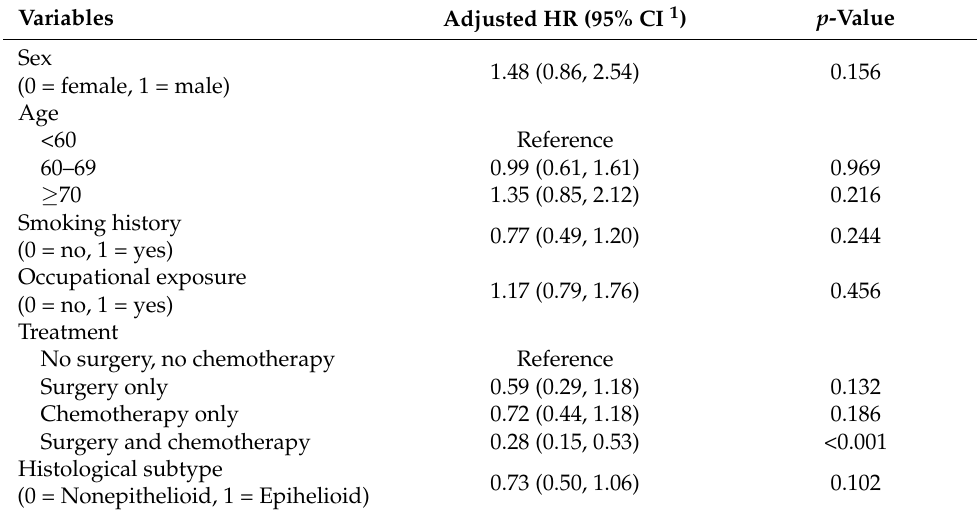
Table 3. Cox’s proportional hazards analysis according to potential prognostic factors for 5-year survival of malignant pleural